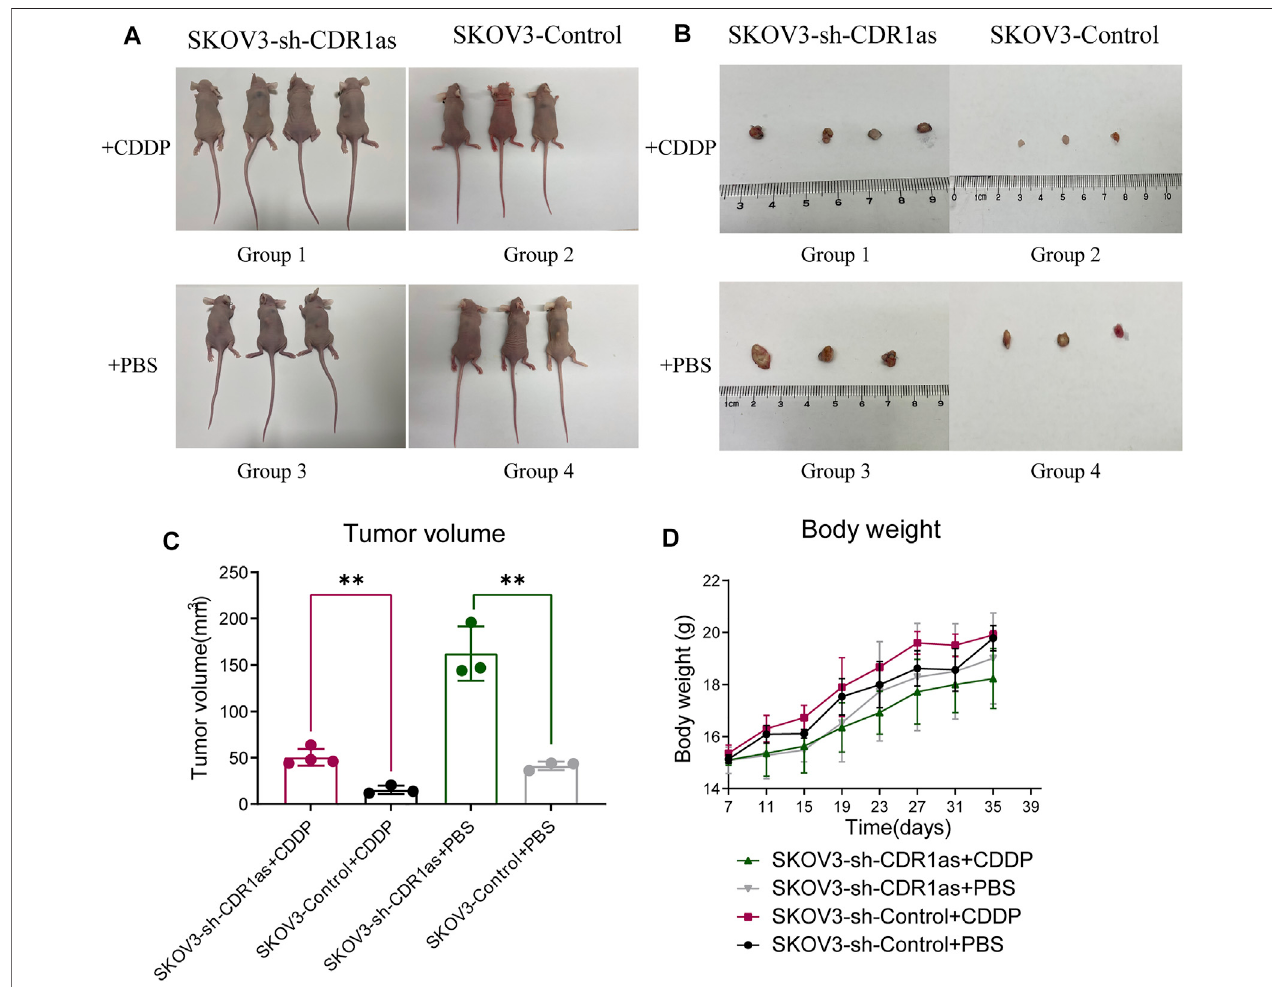
FIGURE 5 | CDR1as promotes CDDP sensitive of OC cells in vivo . (A) The tumor burden of SKOV3 cells transfected with sh-CDR1as or Control lentivirus. (B) The subcutaneous xenograft tumors with or without CDDP treatment were isolated. (C) Tumor volume was measured using a caliper. (D) The growth curves of nude mice body weight. These results were presented as the mean ± SDs. ** p <